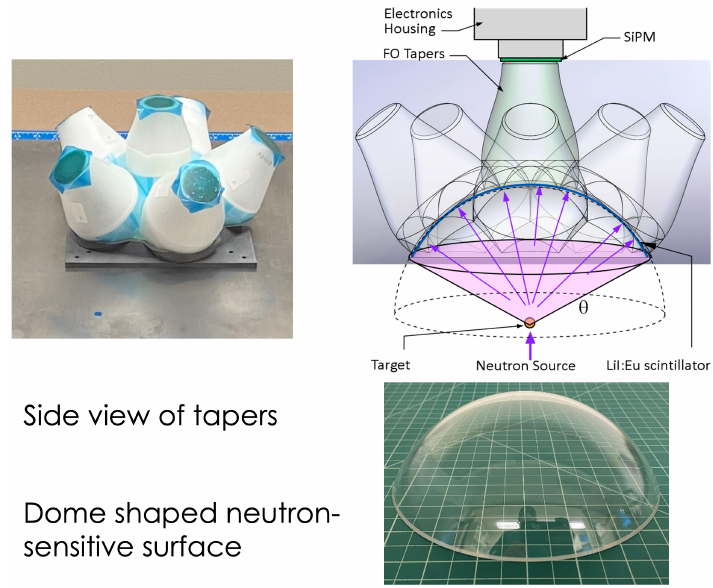
Figure 1. Physical make-up of the dome